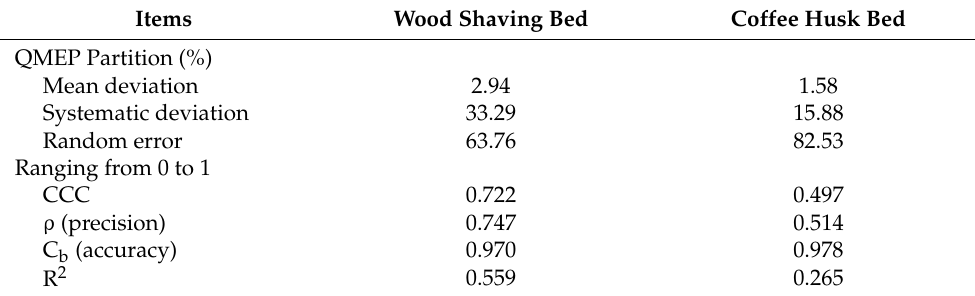
Table 5. Adequacy measurements of the models for the prediction of ammonia generation in wood shavings bed and coffee husks bed, estimated by the cross-validation technique. Items Wood Shaving Bed Coffee Husk